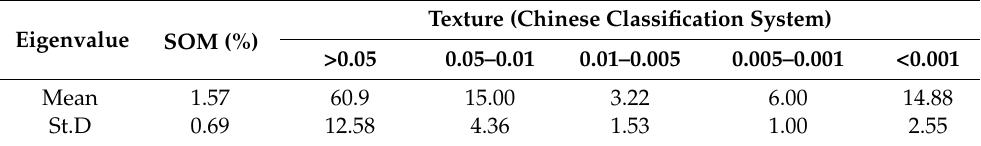
Table 2. Soil properties of the runoff plots in the study